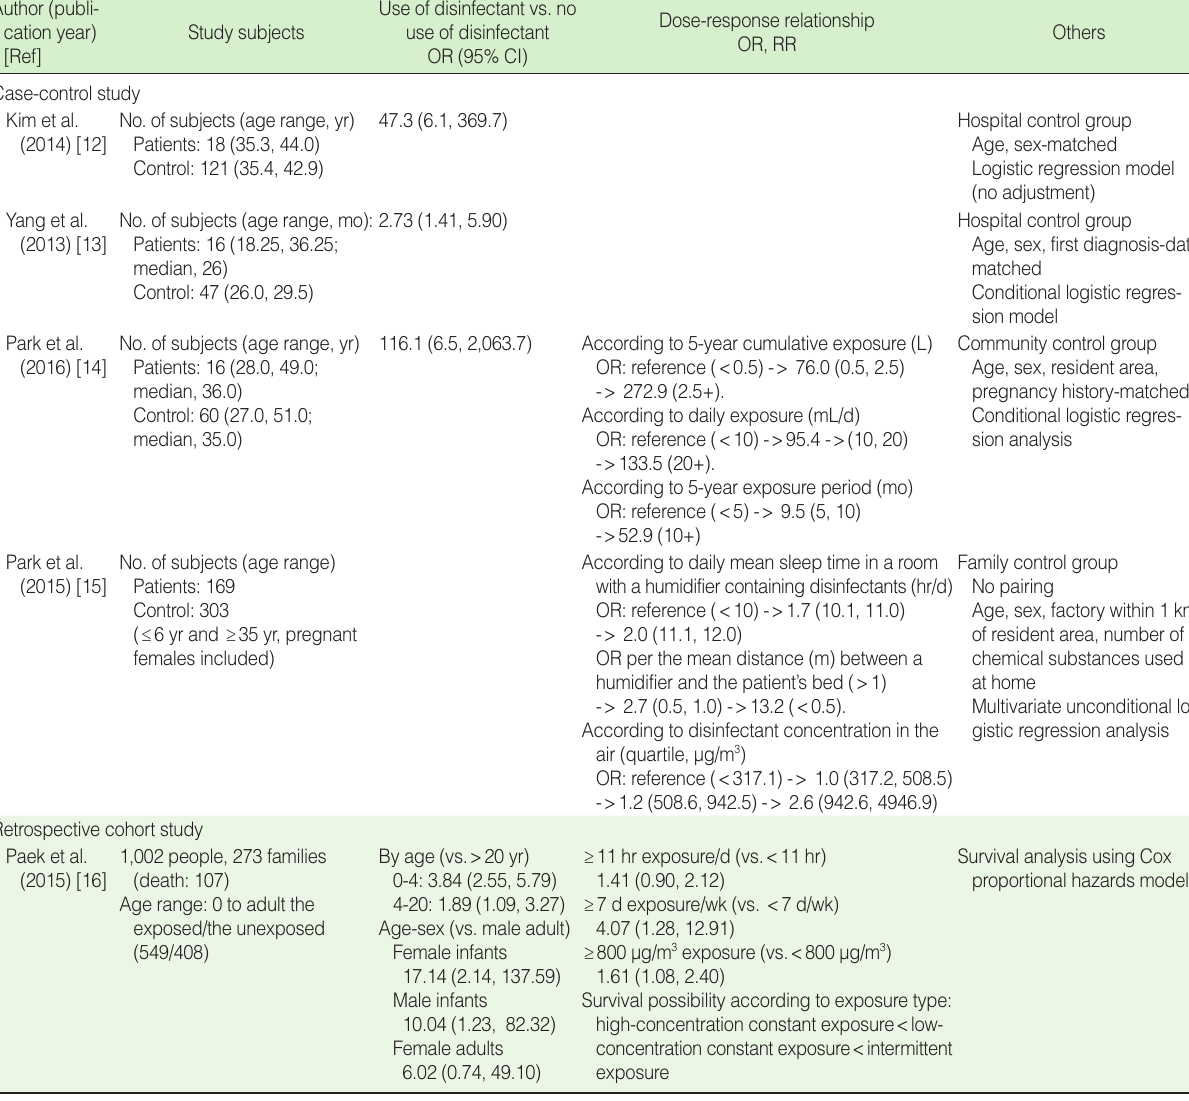
Table 1. Epidemiological studies on the association between humidifier disinfectants and interstitial lung disease of unknown cause since 2011 performed in